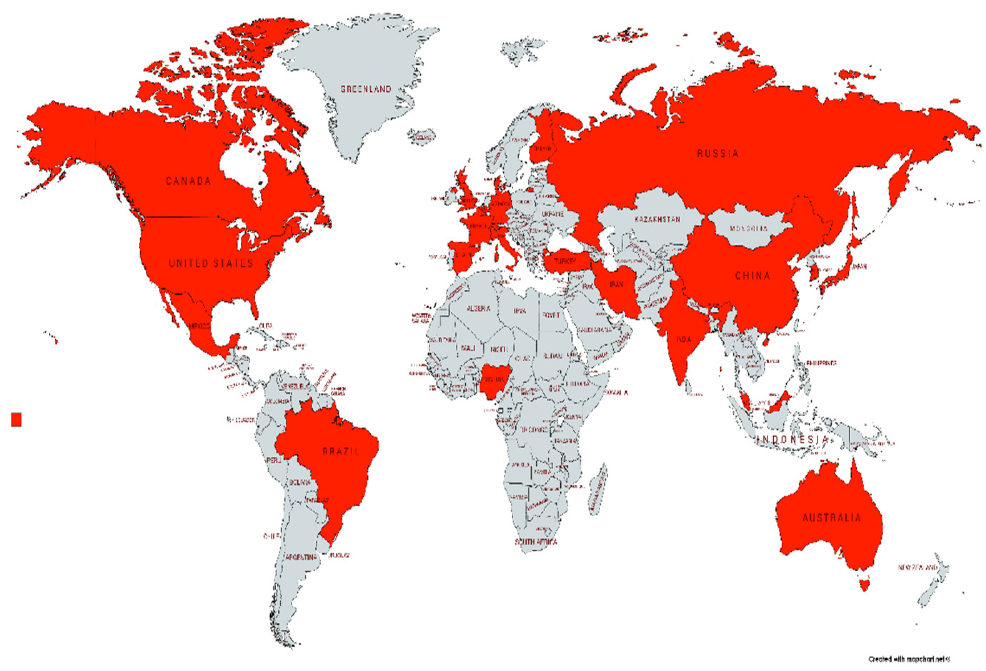
Figure 1. Global map of the countries that were studied through the AI-based methods to predict the trend of the spread of COVID-19 in this review.